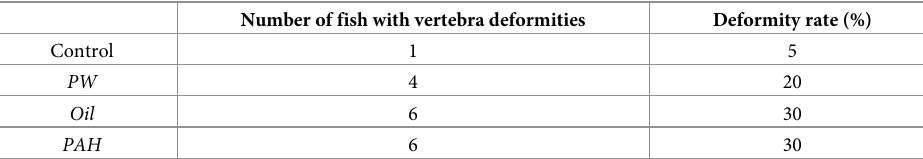
Table 7. Frequency of malformation in PAH exposed